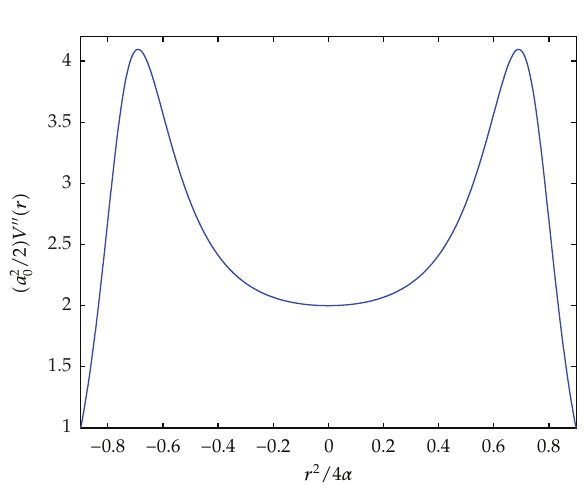
Figure 4: The Reissner-Nordstr¨om wormhole with Q/M (cid:5) 1 . 2 and α (cid:5) 0 . 1, showing a region of stability without the need for a naked singularity.